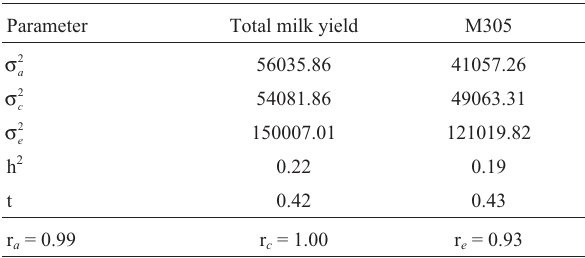
2 ), permanent environmental Table 2 - Estimates of additive genetic ( σ a 2 }) and residual ( σ 2 ) variances (kg 2 ), and estimates of heritability (h 2 ), ( σ c e repeatability (t), genetic (r a ), permanent (r c ) and temporary environmental (r